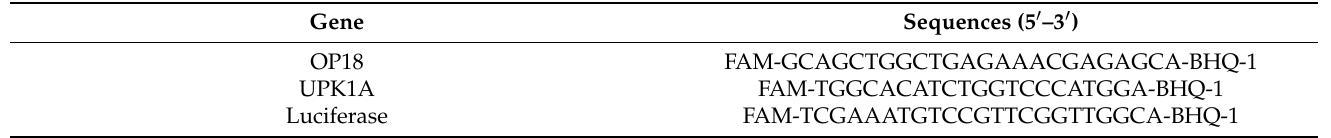
Table 3. TaqMan probes for qPCR-based detection of OP18, UPK1A, and Luciferase,